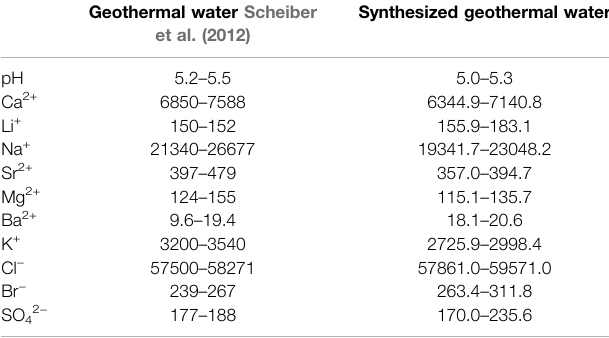
TABLE 1 | Properties of real and synthetic geothermal water (mg/L).